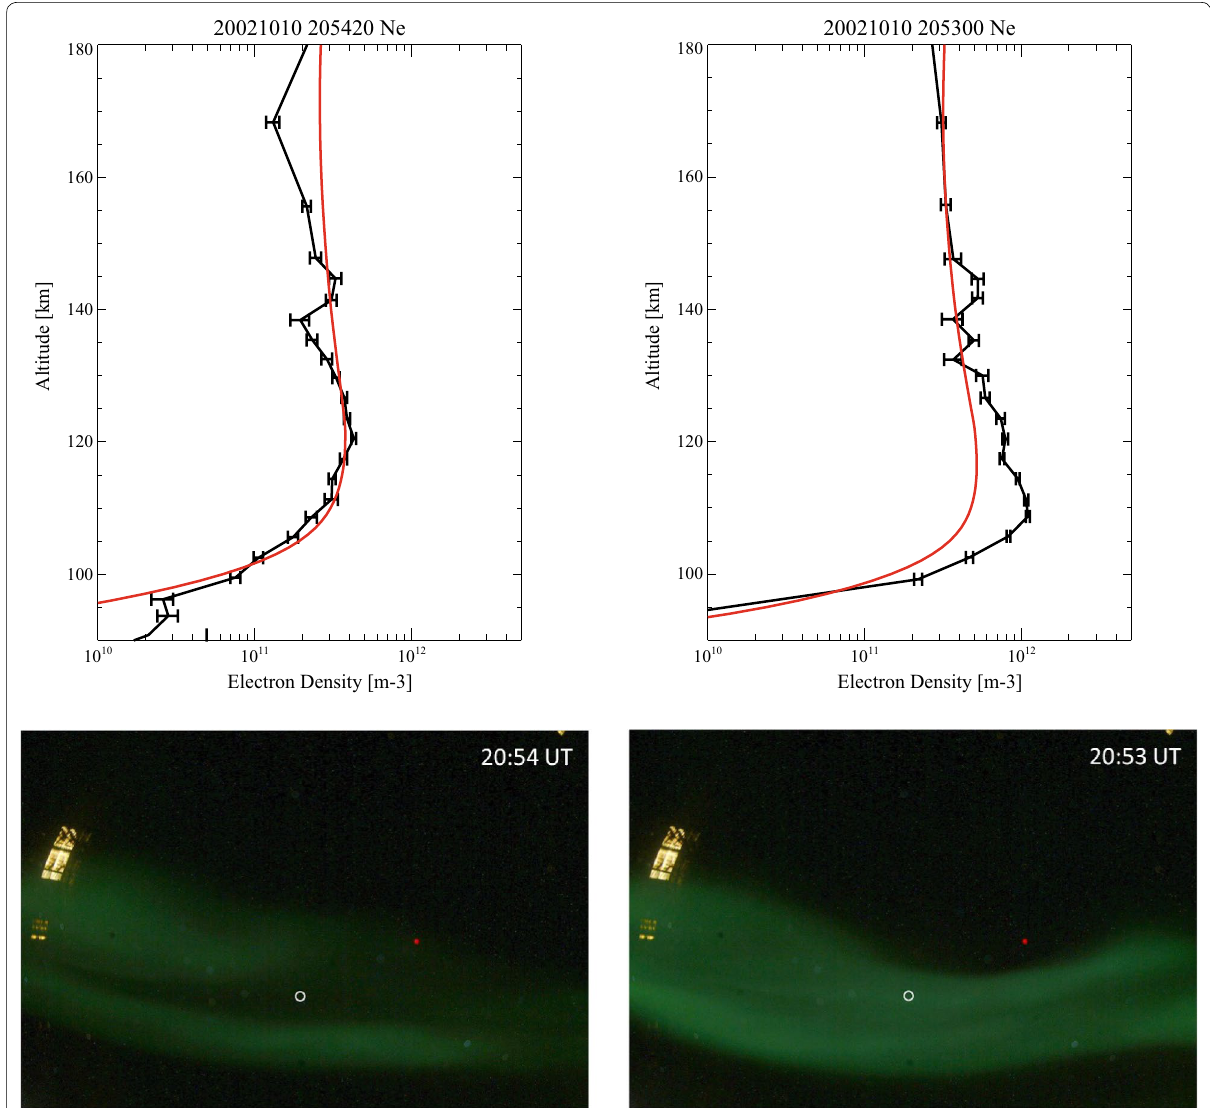
Fig. 12 Comparison of altitude profiles of electron densities; top altitude profiles of electron densities observed by EISCAT ( black solid circles with error bars ) and the photometric method ( red line ) at 2054:20 UT ( left ) and at 2053:00 UT ( right ) on October 10, 2002. Bottom sky color images at 2054 UT ( left ) and 2053 UT ( right ) taken by digital camera on October 10, 2002. White small circles denote the position of the observations (arbitrary size). Red small circle and white rectangle on the left edge are contaminations from artificial